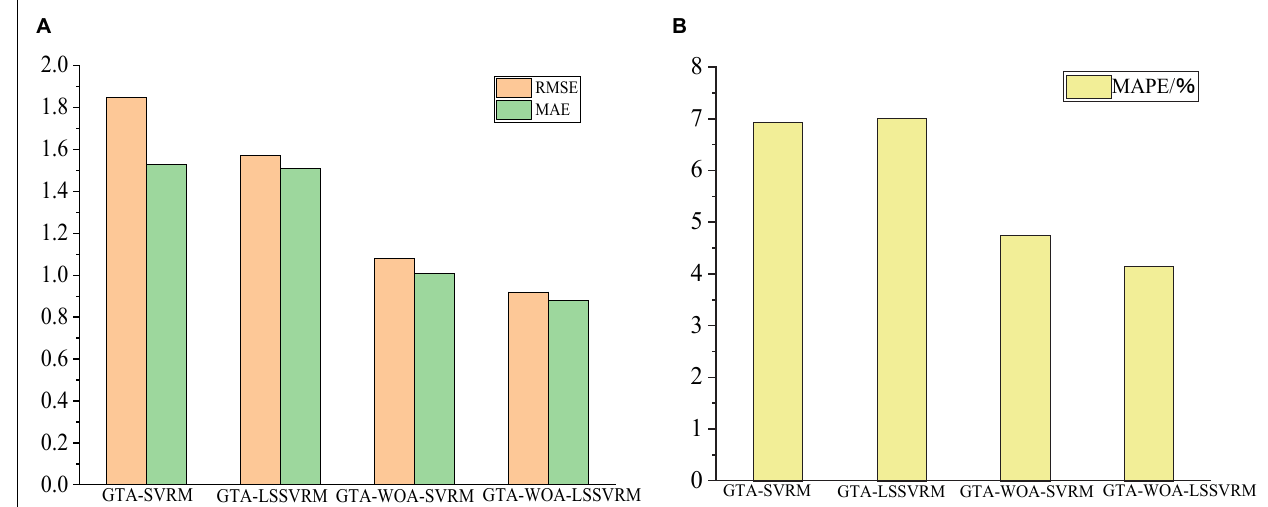
FIGURE 3 | Prediction accuracies of various models. (A) RMSE and MAE (B) MAPE.